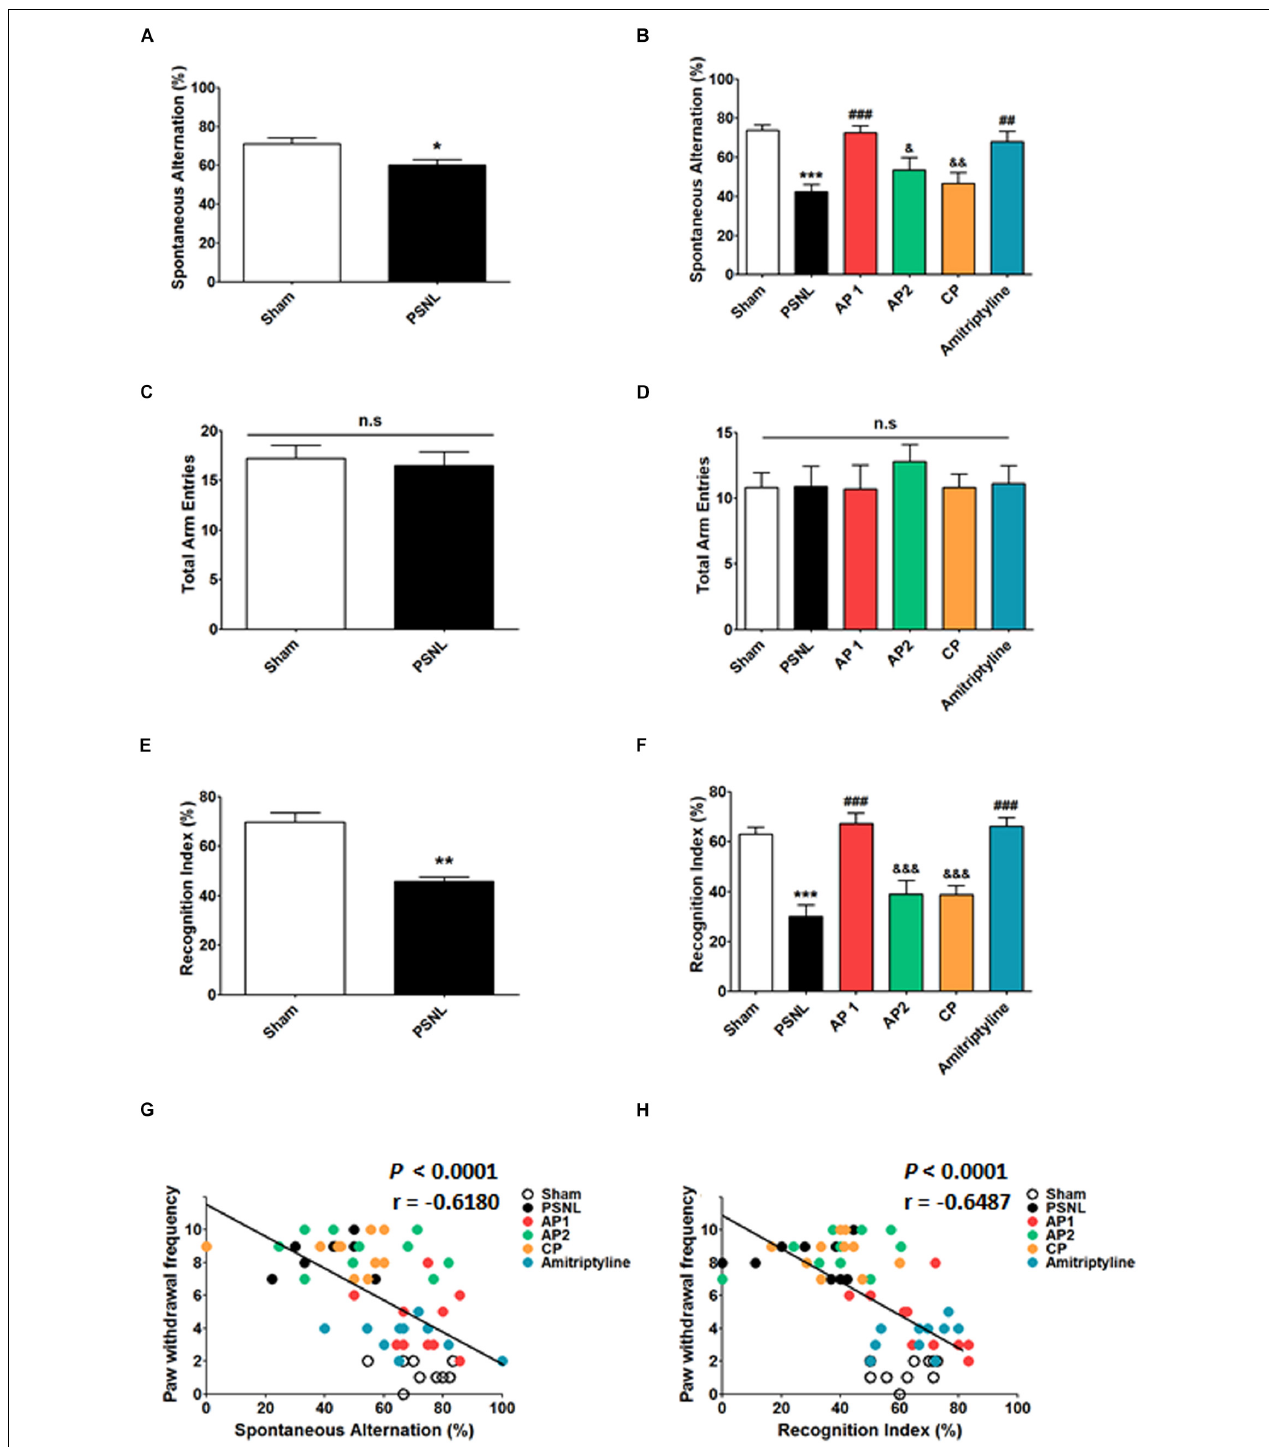
FIGURE 2 | Effects of acupuncture on cognitive functions measured through Y-maze and NOR tests. Effects of acupuncture (AP1, AP2, or CP) or amitriptyline (10 mg/kg, i.p.) treatment on cognitive impairment were investigated using Y-maze (A–D) and NOR (E,F) tests in the PSNL-induced neuropathic pain model. All groups: n = 10. ∗ p < 0.05, ∗∗ p < 0.01, ∗∗∗ p < 0.001 vs. the Sham group, # p < 0.05, ## p < 0.01, ### p < 0.001 vs. the PSNL group, & p < 0.05, && p < 0.01, and &&& p < 0.001 vs. the AP1 group. The data were analyzed with a one-way ANOVA followed by Newman–Keuls post hoc tests (A–F) . Data are expressed as the mean ± SEM. The cognitive function measures in both Y-maze and NOR tests were correlated with paw withdrawal frequency (G,H) . The r -values were analyzed with the Spearman rank correlation coefficient. AP1, acupuncture 1 (GB30 and GB34); AP2, acupuncture 2 (HT7 and GV20); CP, control point; NOR, novel object